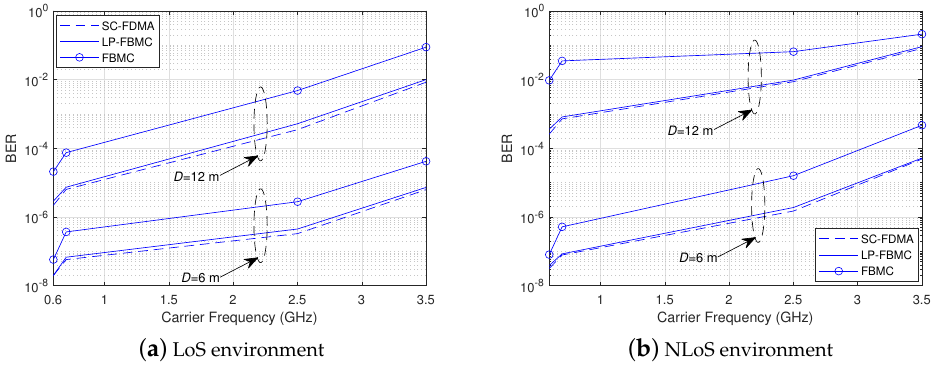
Figure 10. BER of the SC-FDMA, FBMC, and LP-FBMC, according to the distance and carrier frequency, N = 64, ∆ f = 15